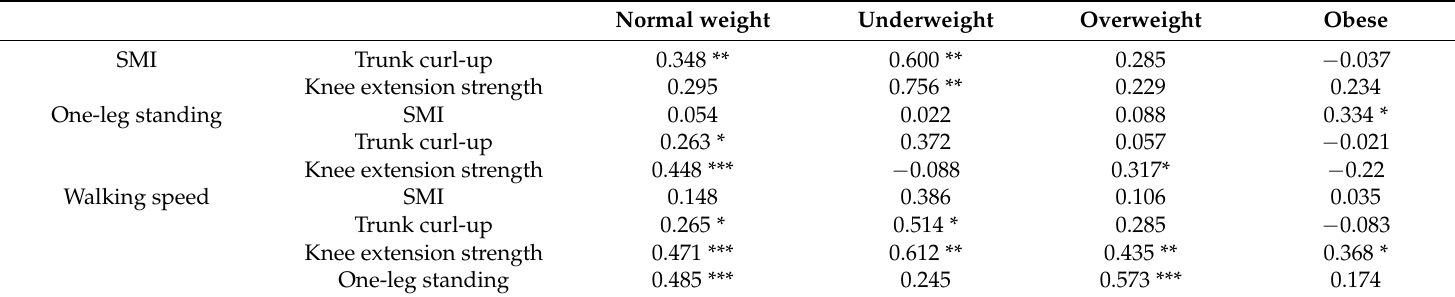
Table 3. Correlation between the physical characteristics in each BMI group. Normal weight Underweight